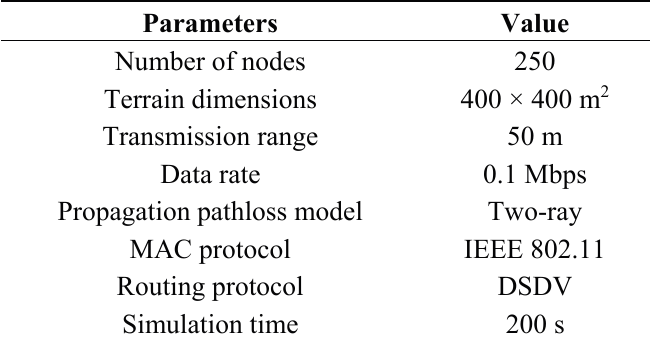
Table 3. Simulation parameters.